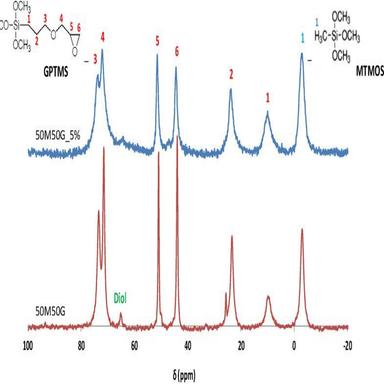
Solid-state 13 C NMR of (a) 50M50G and (b) 50M50G_5%.